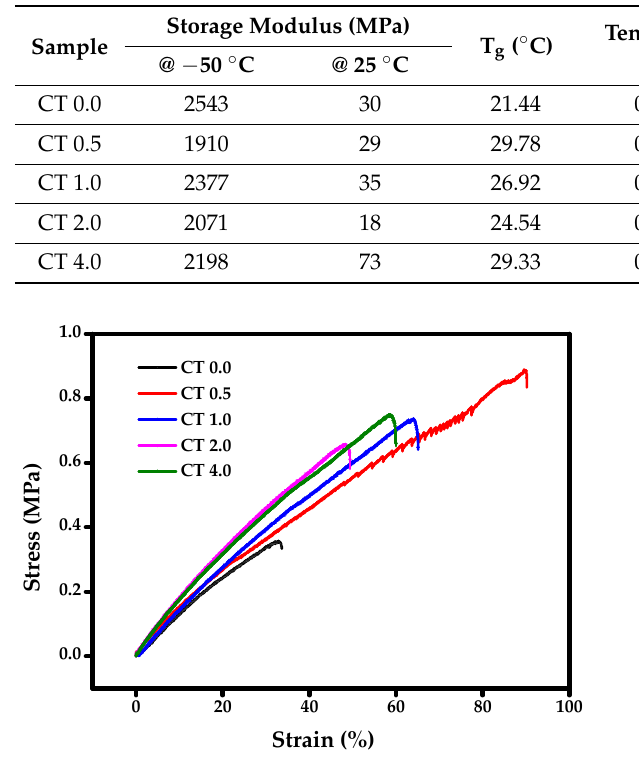
Figure 9. UTM Plot of NIPU Composite Films .